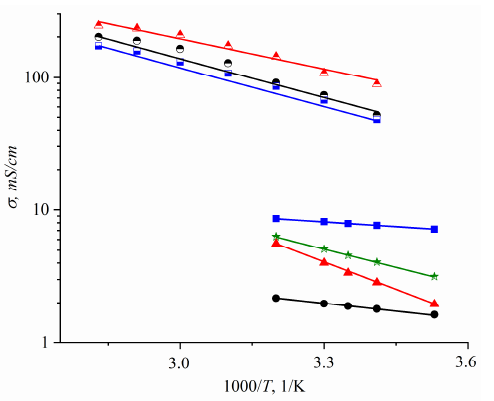
Figure 32. Temperature dependences of the experimental σ exp (1–4) and calculated σ calc (2’–4’) ionic conductivities in the H + (1), Li + (2) and (2’), Na + (3) and (3`), Cs + (4) and (4’) ionic forms of the MSC membrane at RH = 98%. Reprinted with permission from Ref. [35]. Copyright 2020 MDPI. This distinction is typical of membranes based on sulfonated polystyrene.